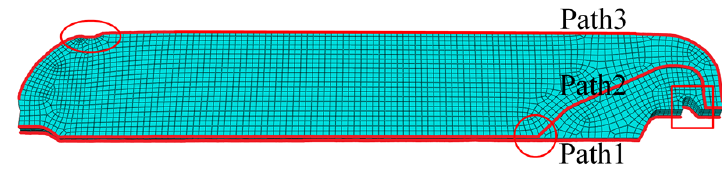
Figure 9. ( a ) Contours of tot To further study the distribution of σ tot curing, three paths as shown in Figure 10 were selected for analysis.